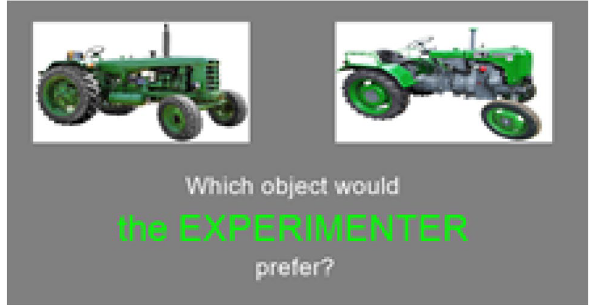
Figure 3. Example items from the preference overlap task.